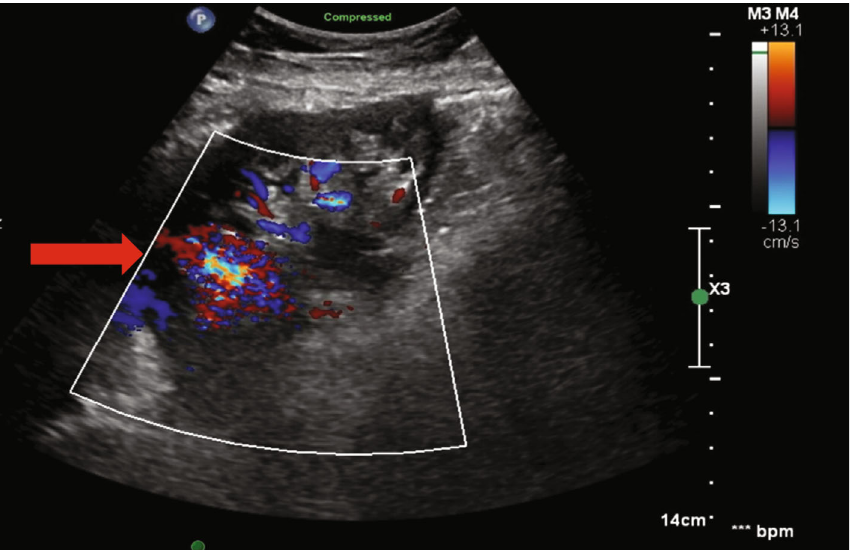
Figure 1: In the superior pole there is a focal area of marked increased fl ow (arrow) with disorganized echoes cyst suggesting an arteriovenous fi stula.